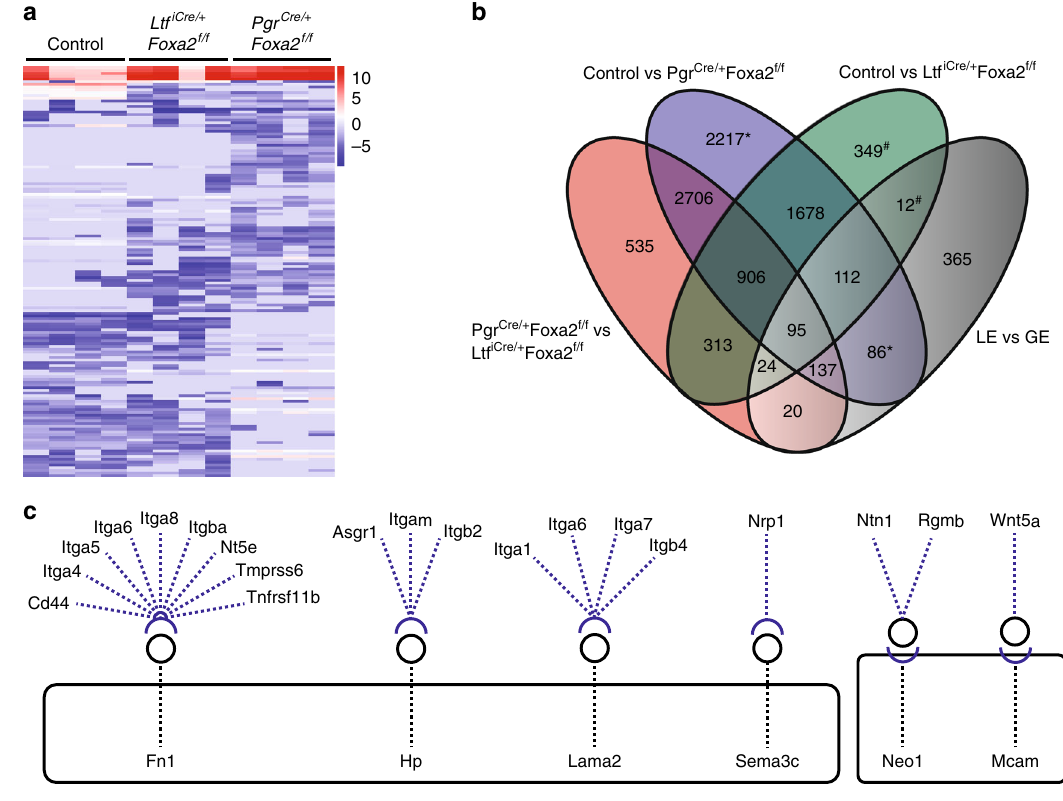
Fig. 1 The uterine transcriptome is dysregulated in mice that lack glands. RNA-sequencing was performed using uteri from gland-containing Ltf iCre/ + Foxa2 f/f glandless Pgr Cre/ + Foxa2 f/f , and control mice on GD 4. a Heatmap of the top 150 differentially expressed genes (log2 FPKM values) in FOXA2- de fi cient mice compared to controls. b Venn diagram comparing unique or common transcripts between the uterus of gland-containing Ltf iCre/ + Foxa2 f/f , glandless Pgr Cre/ + Foxa2 f/f , and control mice on GD 4. The LE vs GE represents genes that were enriched in the GE compared to the LE on GD 4. Superscripts denote genes combined for analysis. c Receptor and ligand interactions between genes uniquely differentially expressed in the uteri of glandless mice that are also enriched in GE on GD 4. Black boxes indicate genes uniquely differentially expressed in uteri of glandless Pgr Cre/ + Foxa2 f/f compared to control mice. Circles represent ligands, and half circles are receptors. All analysis was conducted using four biological